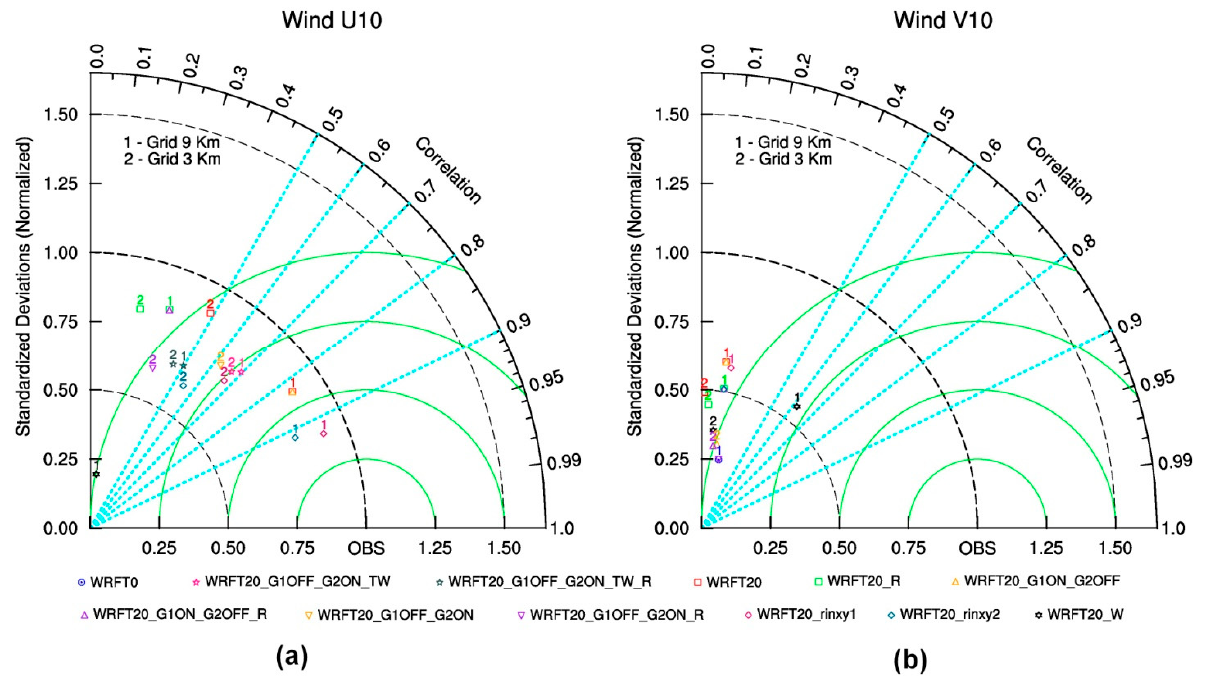
Figure 5. Taylor diagrams, with statistics normalized with respect to observations, for a subset of simulations with data assimilation until 20:00 UTC, except for the control run (blue circles), for the 4April 2019, case study. ( a , b ) The zonal and meridional component of the wind, respectively. Numbers 1 and 2 indicate the outer grid (9 km) and the inner grid (3 km), respectively.